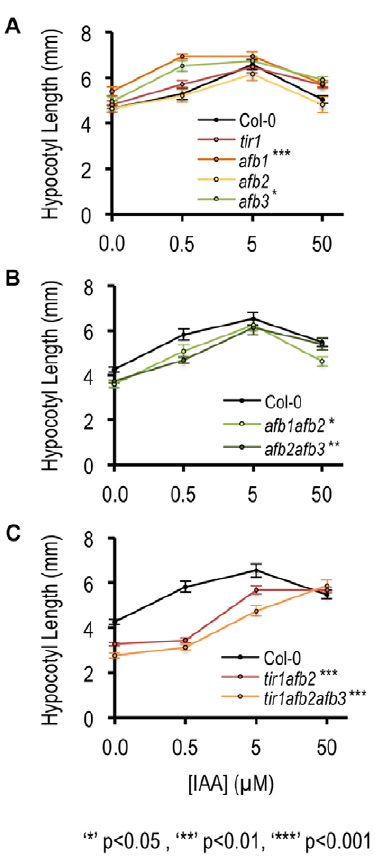
Figure 2. Hypocotyl auxin response requires TIR1/AFB auxin receptors. (A–C) Hypocotyl length of wild-type or tir1/afb single or multiple mutant seedlings grown in short days and treated with IAA at the indicated concentrations was measured following 48 hours of auxin treatment. Asterisks represent mutants showing a significantly different response to hormone treatment compared to wildtype. A general linear model (glm performed in R using the car package [104]) was used to determine significance and main effects for genotype were confirmed using ANOVA type III sums of squares. All assumptions for GLM were fulfilled. Error bars indicate standard